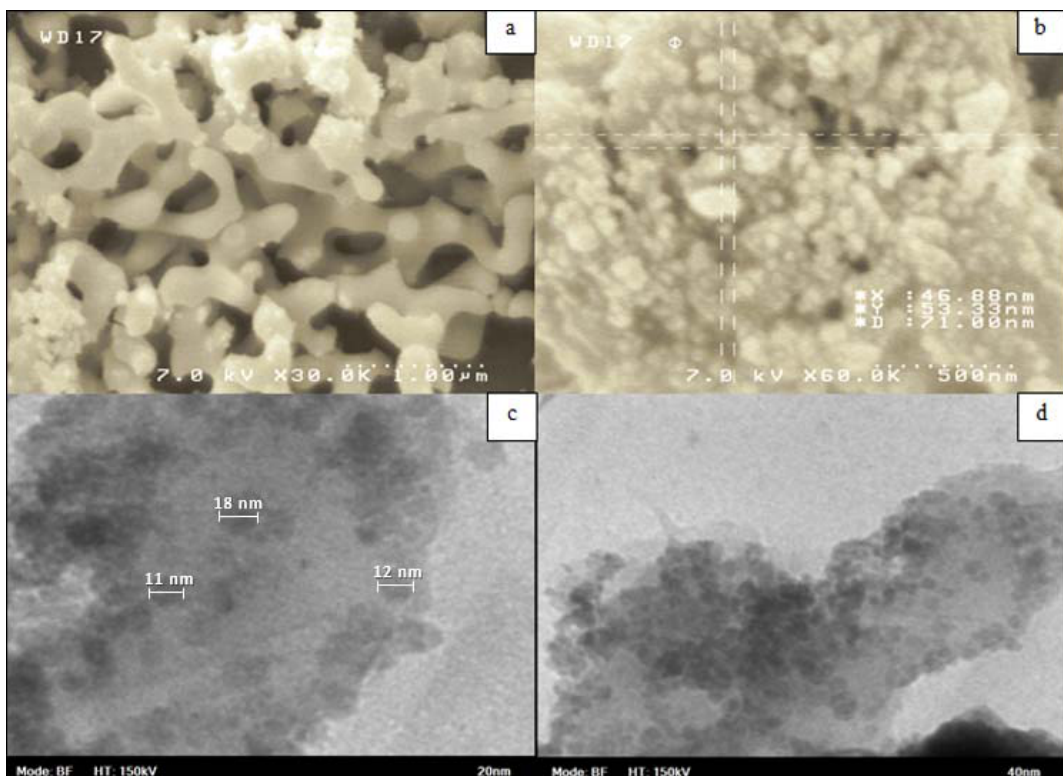
Fig. 2. The XRD pattern of Fe Figure 2. The XRD pattern of the Fe 3 O 4 -GO-NH 2